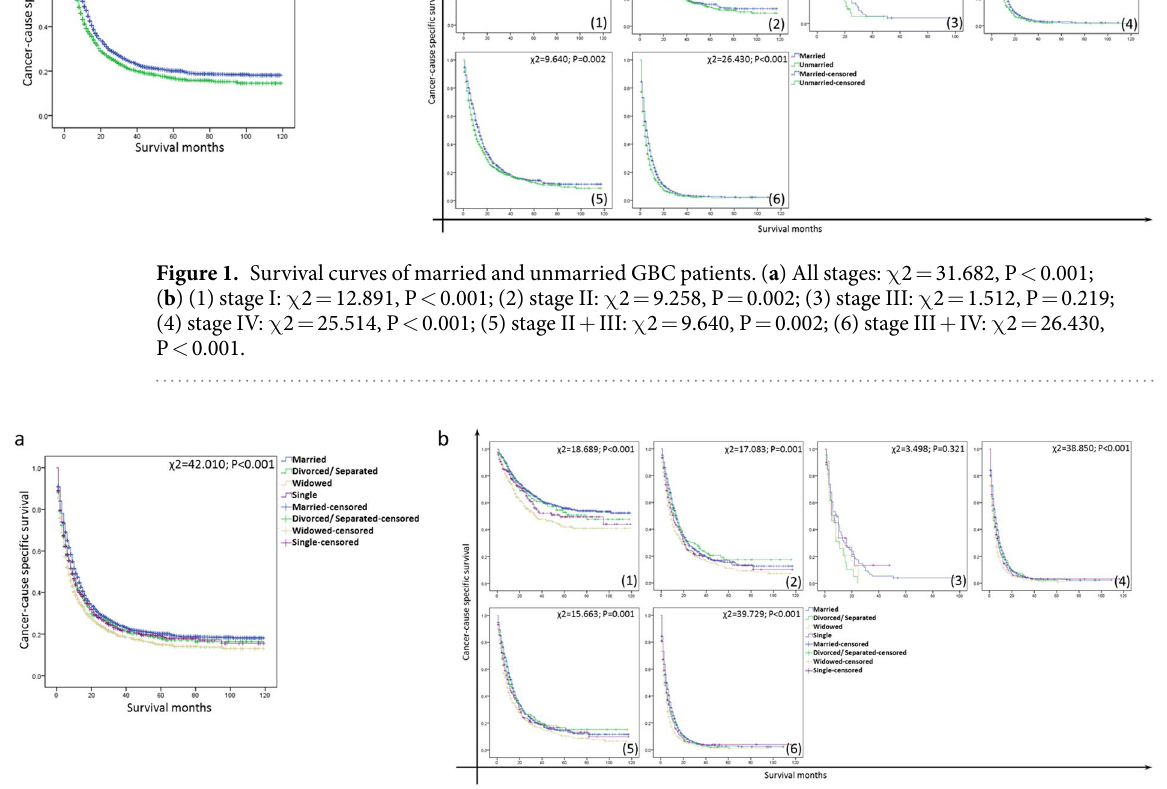
Figure 2. Survival curves of GBC patients with different marital status (married, divorced/separated, widowed and single). ( a ) All stages: χ 2 = 42.010, P < 0.001; ( b ) (1) stage I: χ 2 = 18.698, P < 0.001; (2) stage II: χ 2 = 17.083, P = 0.001; (3) stage III: χ 2 = 3.498, P = 0.321; (4) stage IV: χ 2 = 38.850, P < 0.001; (5) stage II + III: χ 2 = 15.663, P = 0.001; (6) stage III + IV: χ 2 = 39.729, P <